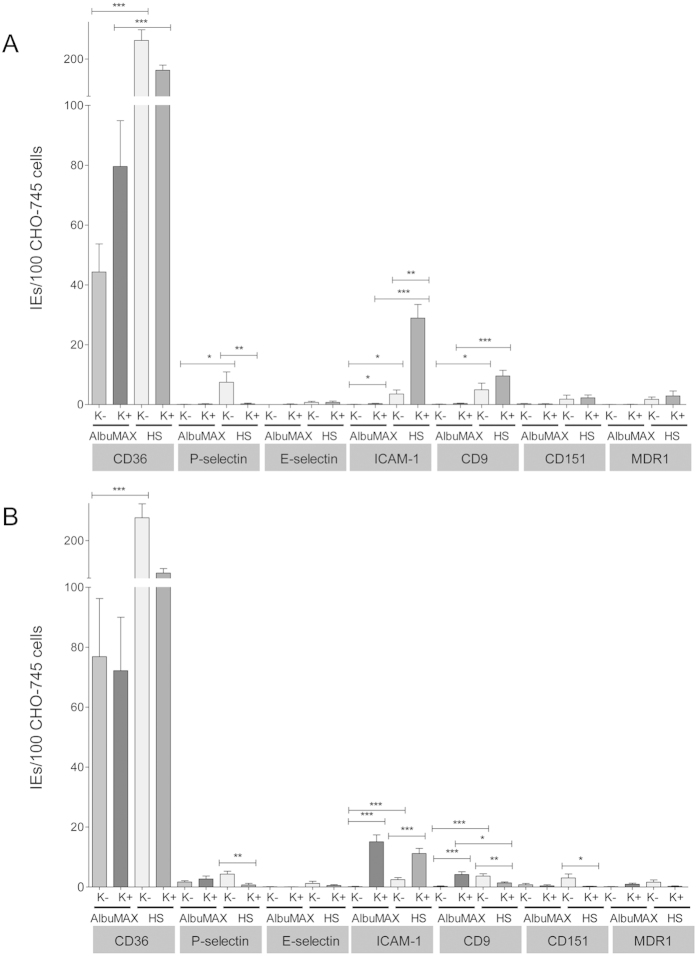
Binding of P. falciparum IEs to endothelial receptors expressed on CHO-745 cells.Binding of erythrocytes infected with isolate 3D7 (A) or isolate FCR3 (B) to CHO-745 cells expressing CD36, P-selectin, E-selectin, ICAM-1, CD9, CD151, or MDR1. Bars indicate the median number of IEs specifically bound to 100 CHO cells (as determined by microscopic inspection of 500 CHO cells in three independent experiments, each performed in triplicate). K−, cultivation in the presence of AlbuMAX or human serum; K+, cultivation in the presence of AlbuMAX or human serum plus gelatin sedimentation to enrich knobby IEs. (*p ≥ 0.05, **p ≤ 0.01, ***p ≤ 0.001).